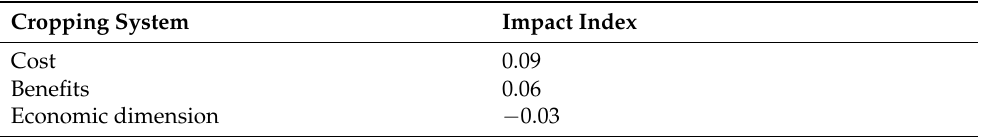
Table 5. Impact index of the economic dimension of SICS as compared to control considered in the CSS of